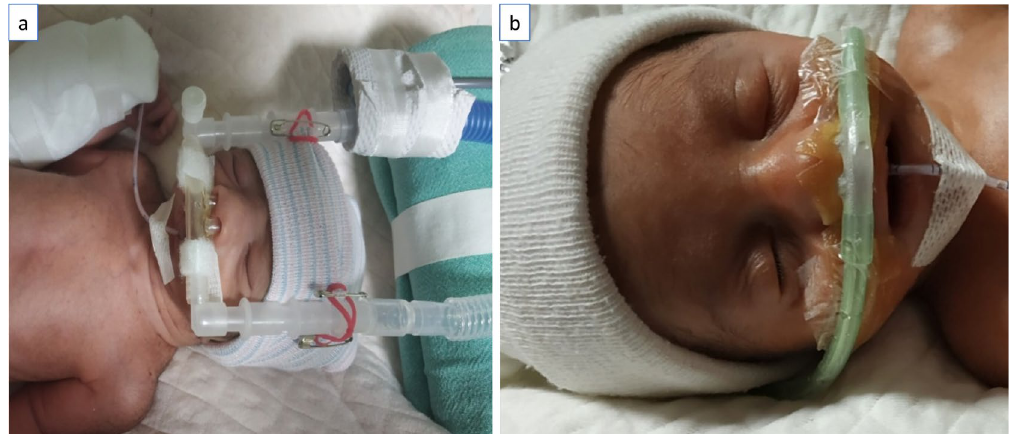
Figure 1. Representative clinical images of Hudson prongs ( a ) and Ram cannula ( b ) as nasal interface for delivering nasal continuous positive airway